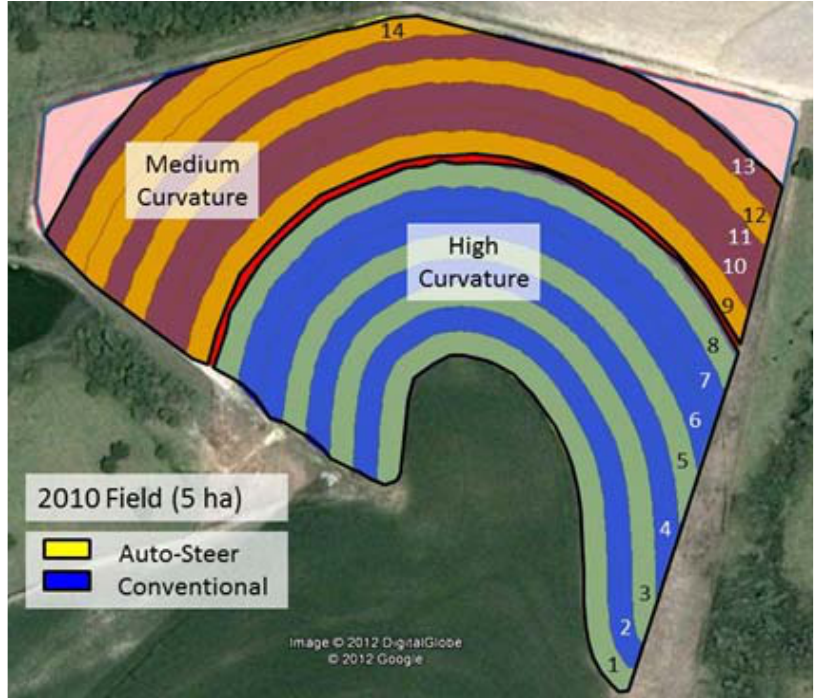
Figure 7. The 2010 field was divided into high and medium curvature